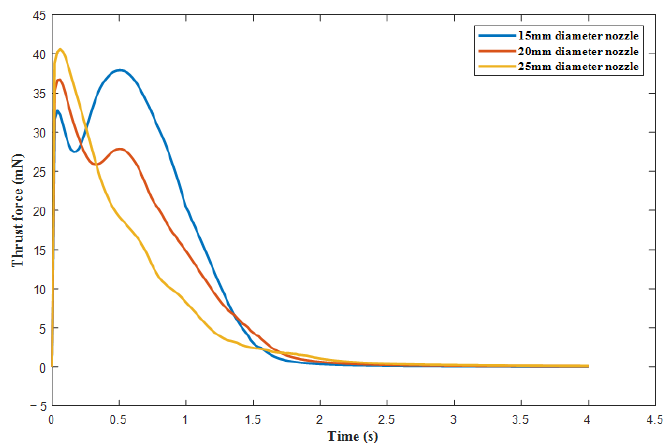
Figure 13. Time variation curve of thrust forces with different nozzle diameters.